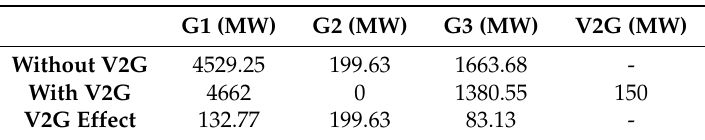
Table 2. The total production of thermal units with and without the presence of vehicle-to-grid (V2G) for a 24-h